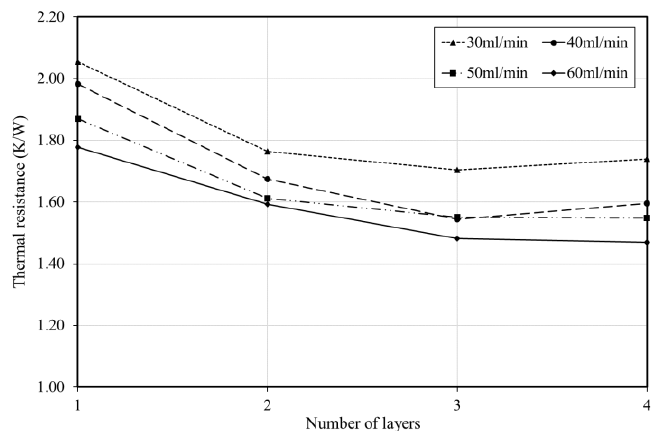
Figure 17. Heat sink thermal resistance versus number of layers for different HTF flow rates for 5 W.